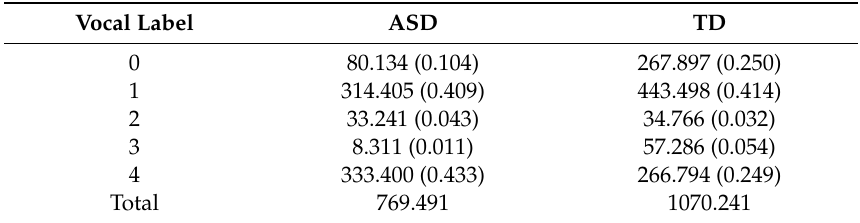
Table 3. Amount (ratio) of each type of vocalization in